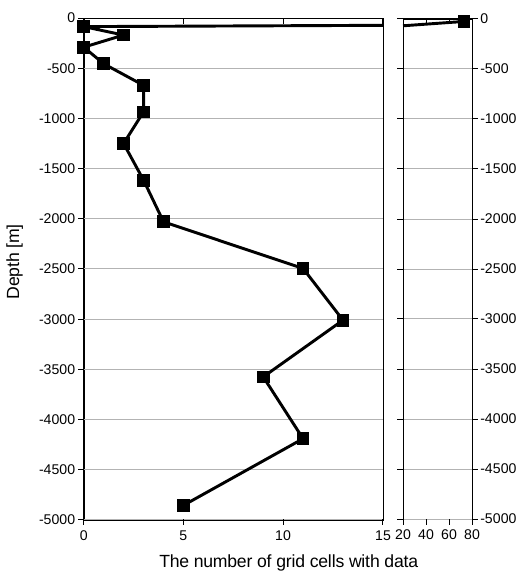
Fig. 5. Vertical distribution of the data in the North Atlantic Ocean. The number of grid cells that contain any data in the domain illus- trated in Fig. 4 is shown as a function of